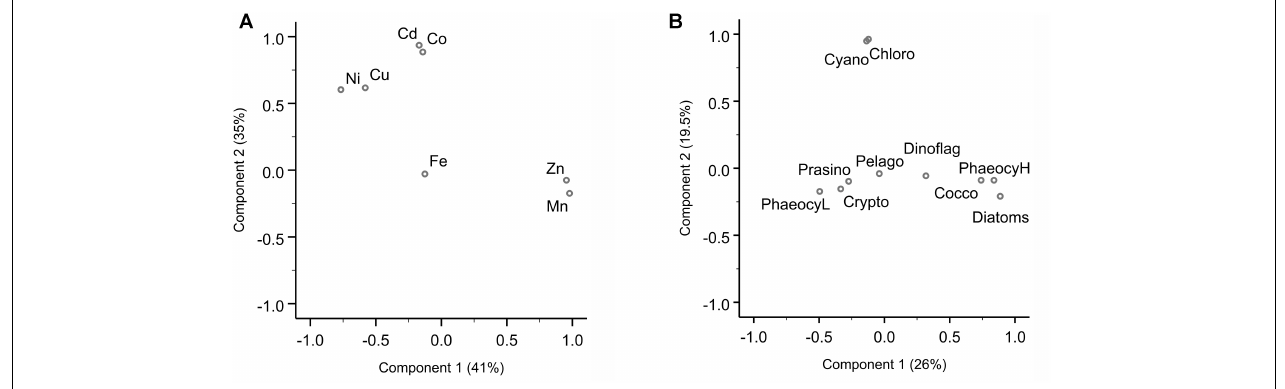
FIGURE 3 | Principal component analysis (PCA) for dissolved trace metal and phytoplankton composition. (A) PCA loading plot of trace metal distribution, where component 1 explains 41% and component 2 35% of the variance. A third component (not shown here) accounts for 22% of the variance ( Supplementary Table S3 ). (B) PCA loading plot of phytoplankton groups, where component 1 explains 26% and component 2 19.5% of the variance. The PCA were carried out in SPSS. Varimax rotated principal components are